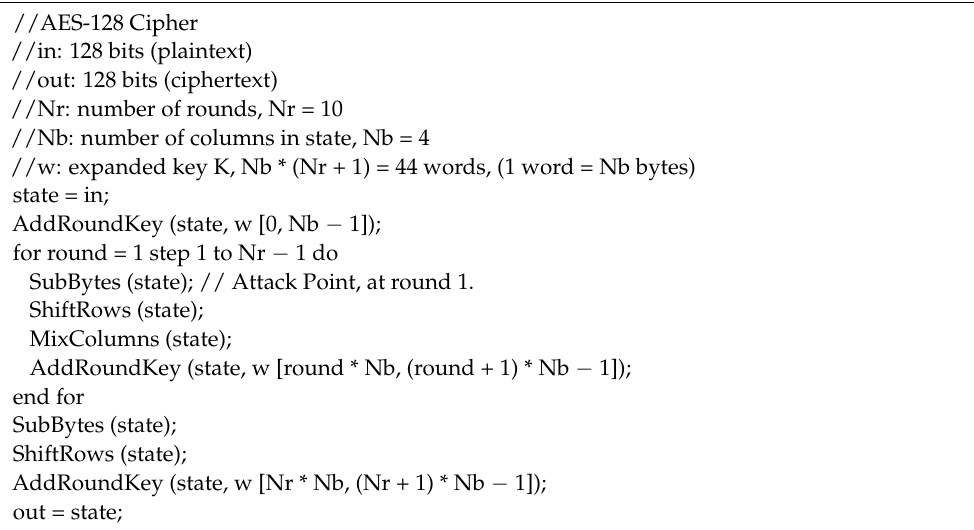
Algorithm 1: Preudocode of the AES-128